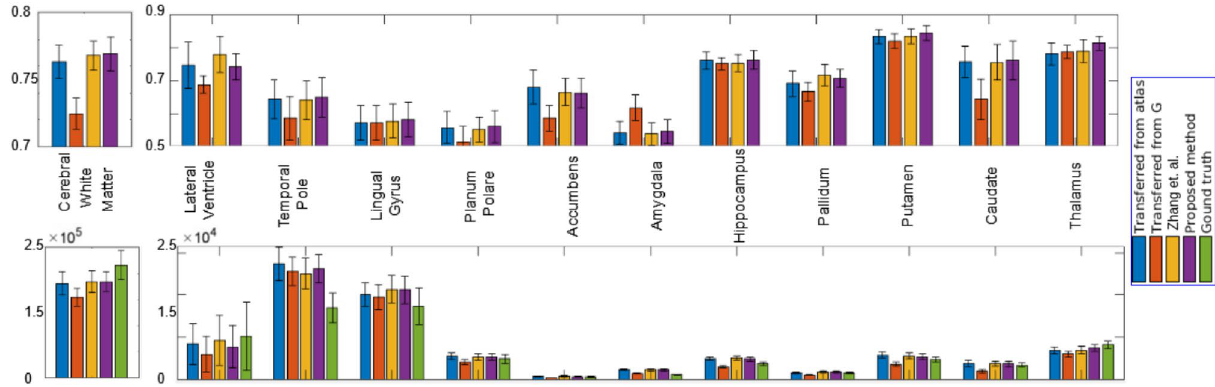
Figure 9. Segmentation performance comparison of the proposed method with Zhang et al. 29 . Baselines for 12 structure